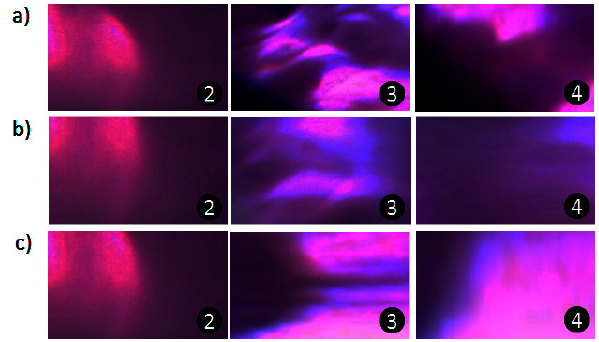
Figure 11. Microphotographs of the fabricated device showing ( a ) an overall view of the device; ( b ) the SEM image of the cross-section of the bonding channel; ( c ) the connection of the sample channel and mixing channel; and ( d ) the surface of the mixing channel. Length of mixing channel = 500 µm, applied potential = 300 V/cm.